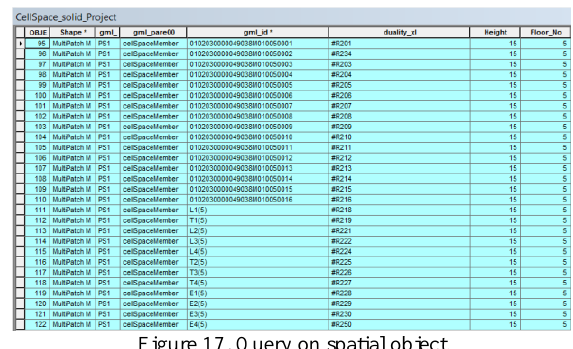
Figure 17. Query on spatial object